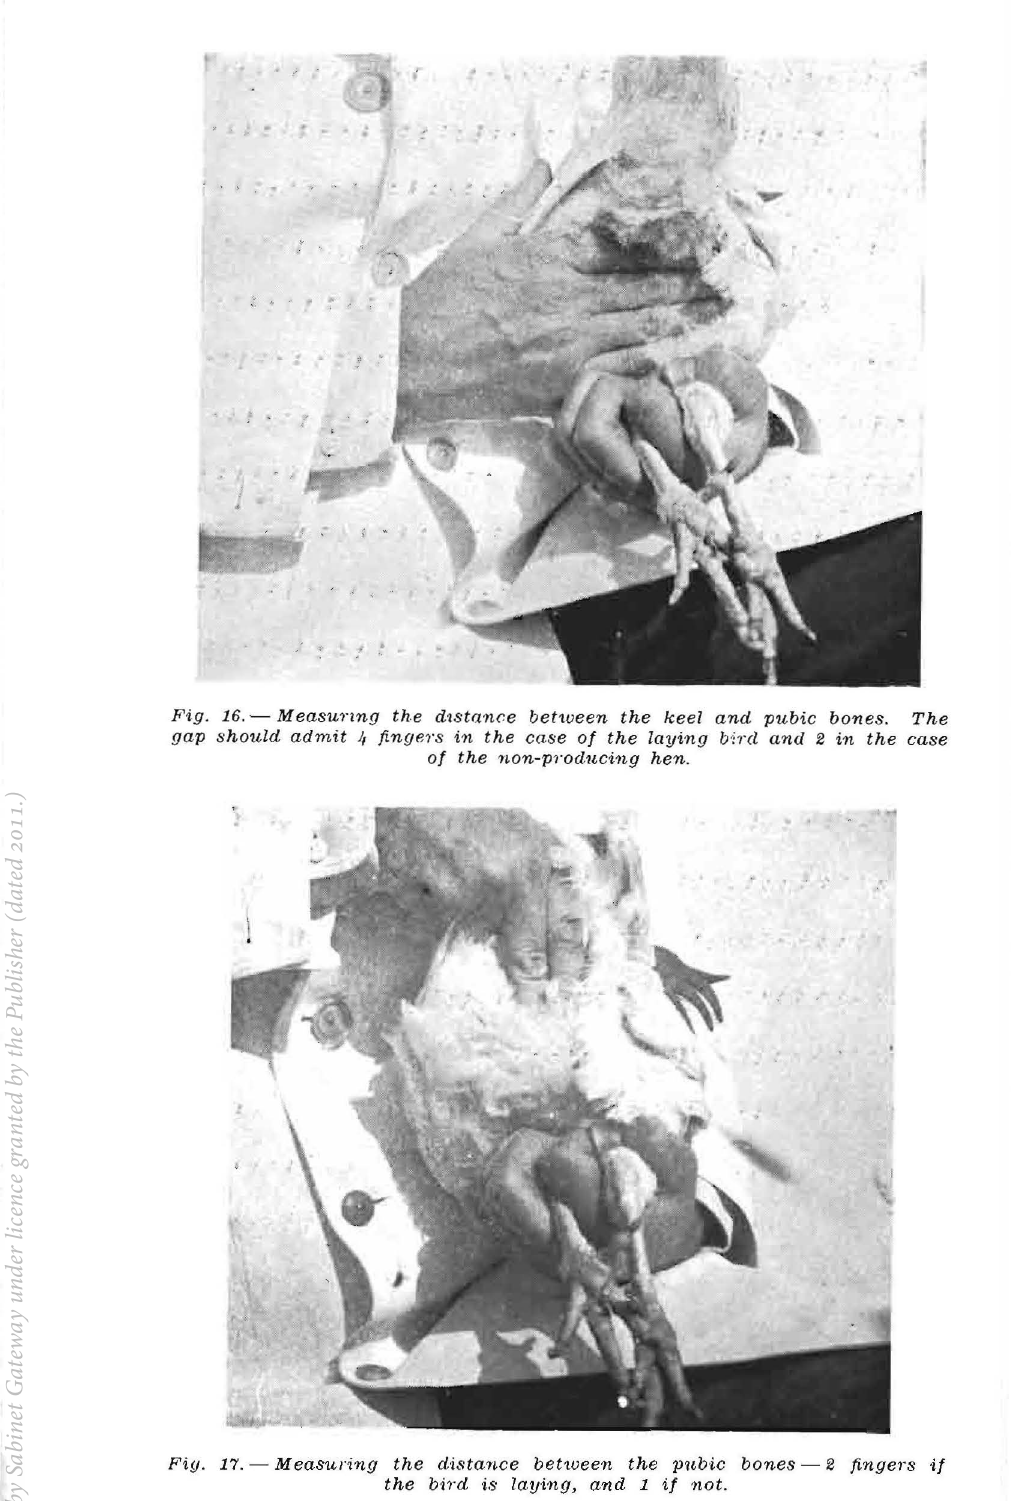
Fig. 17. - Measuring the distance between the pubic bones - 2 fingers if the bi?·d is laying, and 1 if